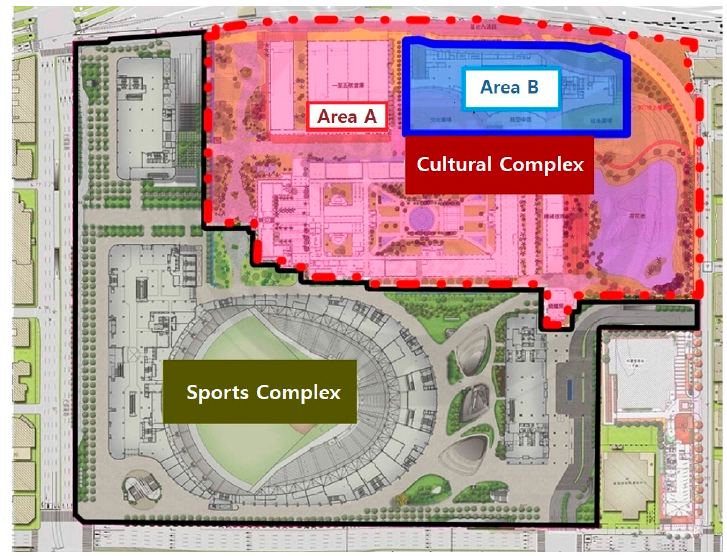
Figure 5. Songshan Cultural Creative Park [29] (p. 31).